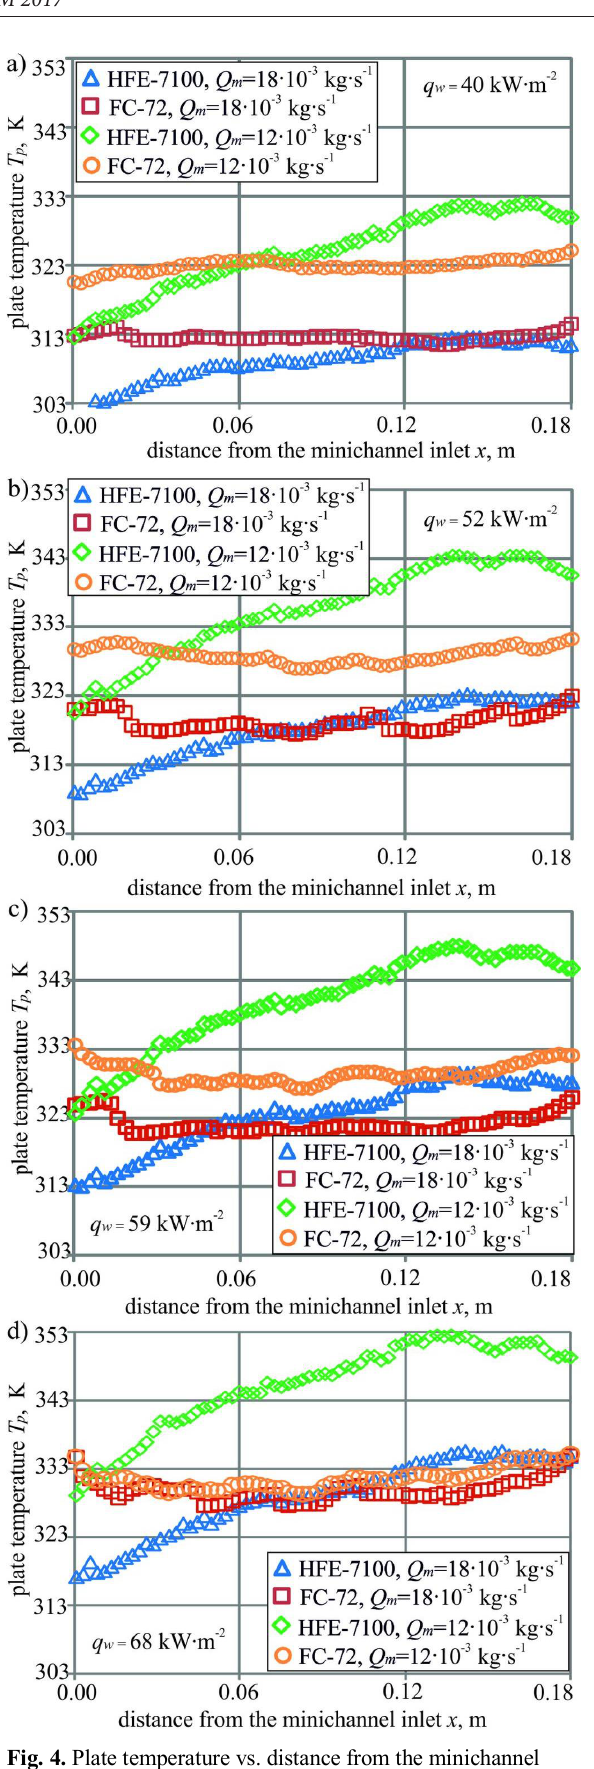
Fig. 4. Plate temperature vs. distance from the minichannel length obtained for the subcooled boiling region, experimental parameters shown in Table 1.